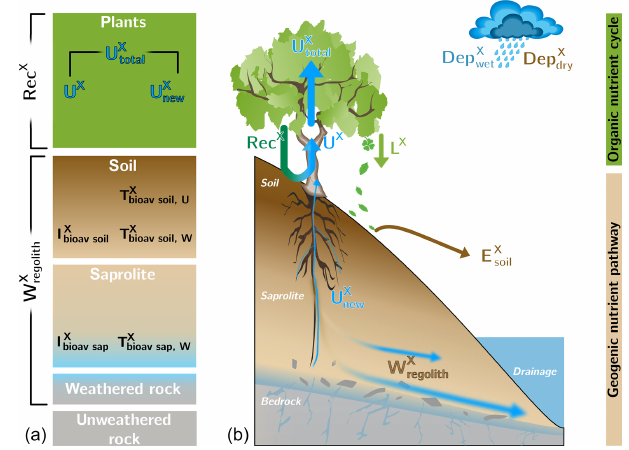
Figure 2. Conceptual framework of an ecosystem comprising the “geogenic nutrient pathway” and the “organic nutrient cycle” (mod- ified from Uhlig and von Blanckenburg, 2019). Whereas the former is mainly set by mineral nutrient release by weathering ( W X ) regolith and to a minor extent by atmospheric wet (Dep X wet ) and dry deposi- tion (Dep X ), the organic nutrient cycle is mainly affected by nutri- dry ent reutilization (i.e., recycling; Rec X ) from organic matter. (a) The different compartments (i.e., rock, saprolite, soil, and plants) are shown as boxes. They include the metrics used to quantify their properties, such as the inventory I X and turnover time T X of el- bulk i , j ement X in compartment j . (b) The compartments are linked by fluxes (arrows) with the thickness of them denoting their relative proportions. E X denotes erosion of soil